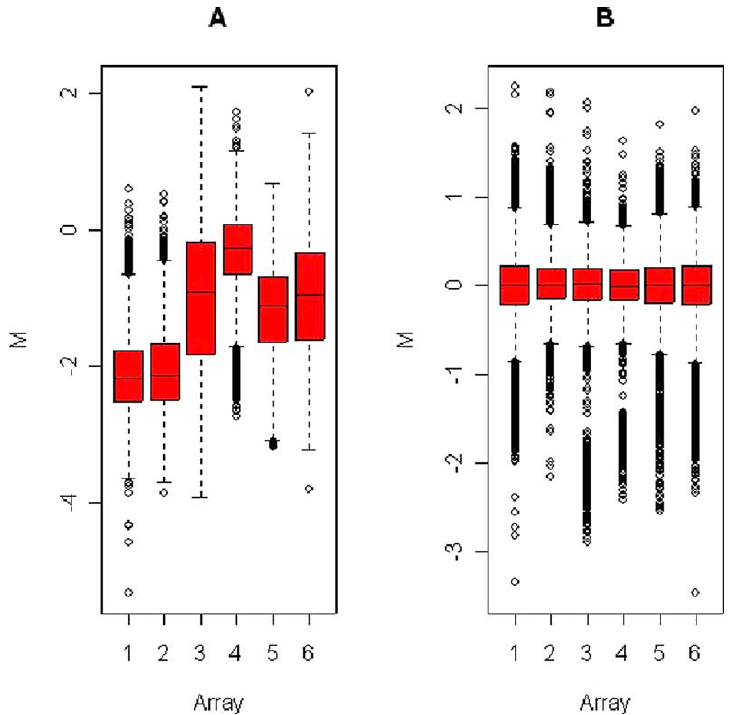
Fig. 4. Boxplots showing the distribution of M values in each of 6 arrays hybridized as part of the same experiment, before (left) and after (right) scale normalization. Data courtesy Prof. A.B. Smit, Department of Molecular and Cellular Neurobiology, Vrije Universiteit, Amsterdam, The